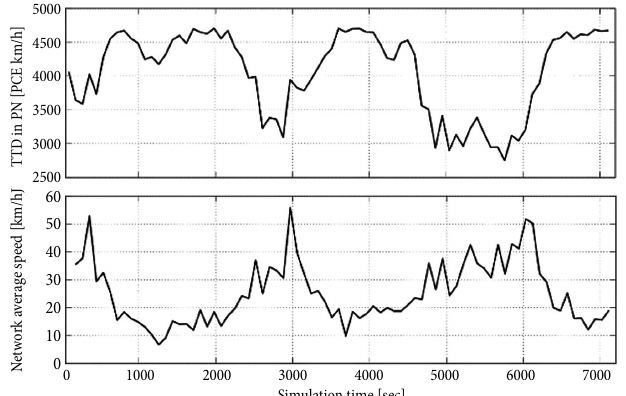
Fig. 9. Scenario 2: network